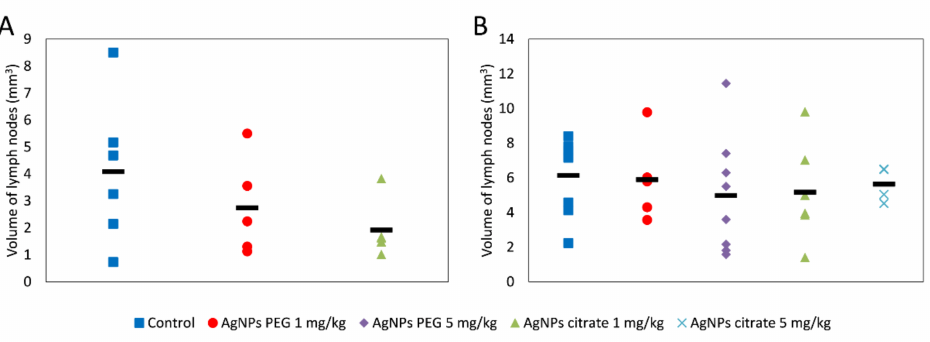
Figure 2. The summed volume of axillary and inguinal lymph nodes located on the same side of the body as the tumor in mice treated intragastrically ( A ) or intravenously ( B ) with citrate- or PEG-coated AgNPs. The black rectangle represents the mean and the markers represent data from individual mice. The differences are not statistically significant, n =